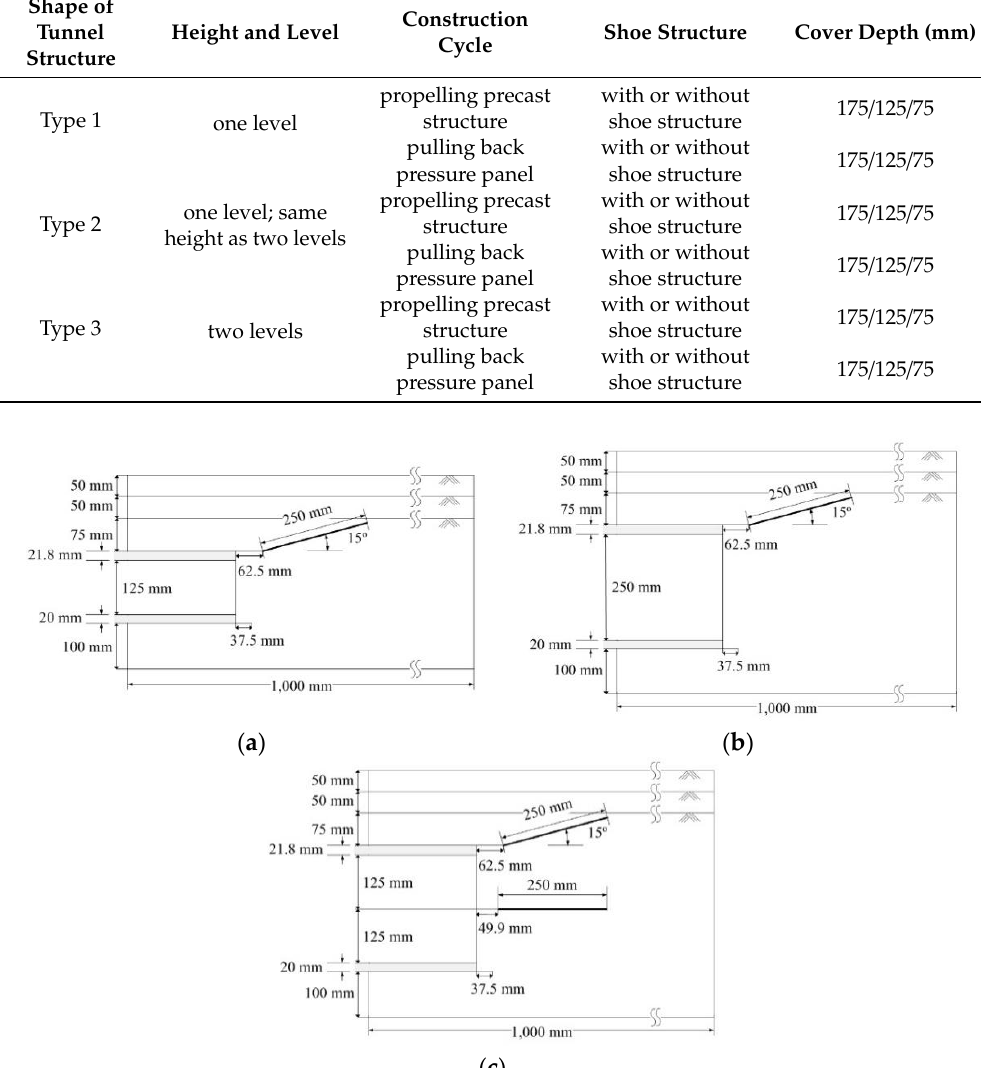
Table 3. Test scenarios of model tests.